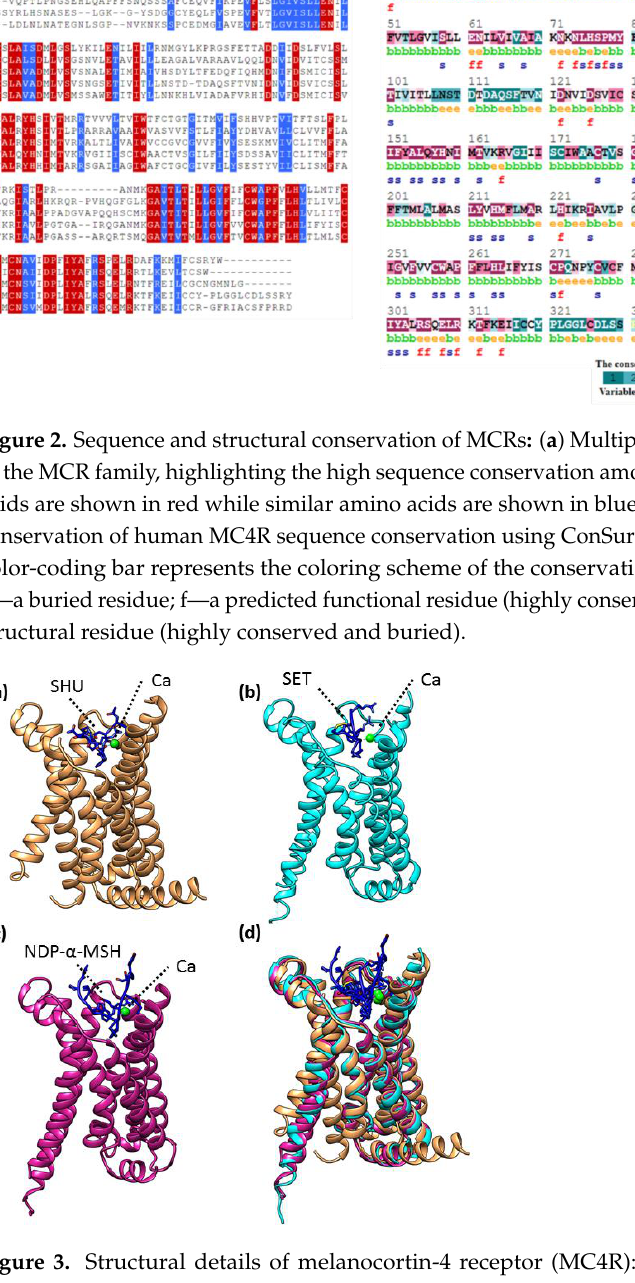
Figure 3. Structural details of melanocortin-4 receptor (MC4R): ( a ) The crystal structure of the MC4R in complex with SHU9119 (antagonist) (PDBID: 6W25). MC4R is shown in brown ribbons, SHU9119 in blue sticks, and Ca 2+ in light green. ( b ) The Cryo-EM structure of MC4R in complex with setmelanotide (SET, agonist) (PDBID: 7AUE). MC4R is in cyan, setmelanotide (SET) is in blue, and Ca 2+ is presented in light green. ( c ) Cryo-EM structures of MC4R in complex with NDP- α -MSH (agonist) (PDBID: 7PIV). MC4R is shown as magenta, NDP- α -MSH in blue, and Ca 2+ is presented in light green. ( d ) Superposition of MC4R structures in complex with SHU9119 (antagonist), setmelanotide (SET, agonist), and NDP- α -MSH (agonist). MC4R is shown in brown, cyan, and magenta as bound to SHU9119, SET, and NDP- α -MSH, respectively. Calcium ions are shown as light green and all ligands as blue.